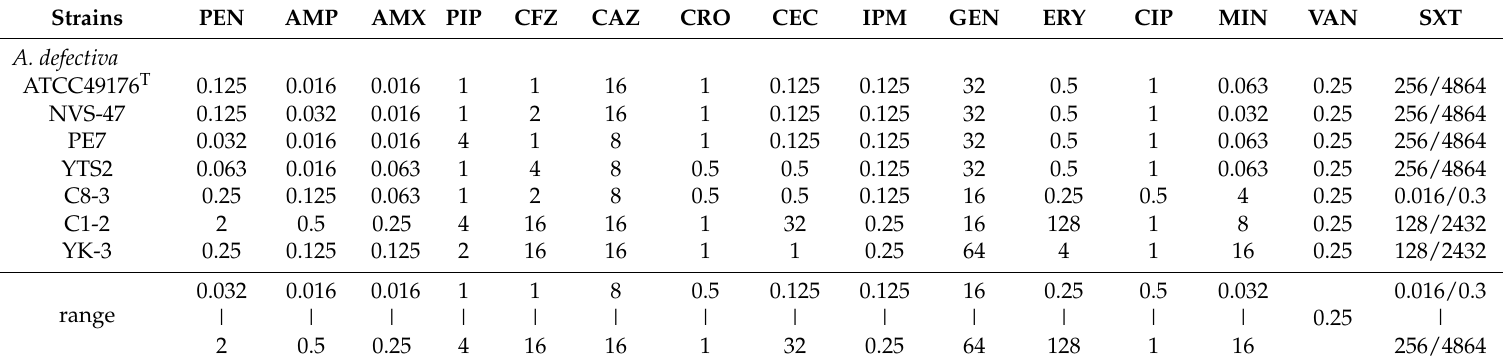
Table 1. MICs ( µ g/mL) of 15 antibiotics against Abiotrophia isolates.